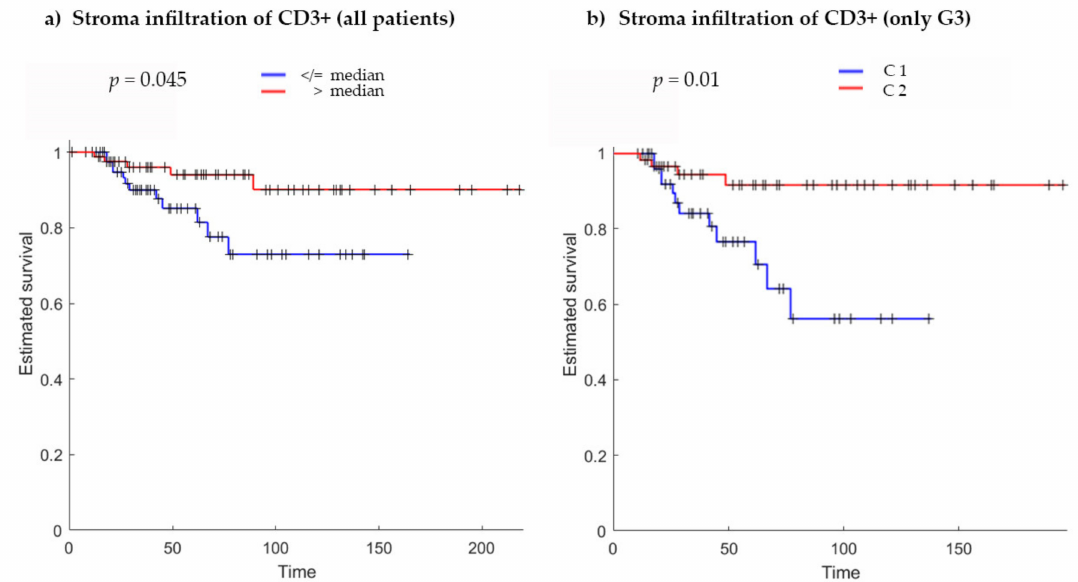
Figure 1. Kaplan–Meier curves for ( a ) stromal infiltration of CD3 + immune cells (all patients) using the median (2882 cells / mm 2 ) as threshold to divide patients into two groups ( p = 0.045). ( b ) Stromal infiltration of CD3 + immune cells (only in G3 subgroup) using the k -means clustering approach ( p = 0.01). C1 with low and C2 with high immune cell infiltration. In each graph, Kaplan–Meier curves present a significant di ff erence between the two groups, showing an increased survival in patients with higher immune cell infiltration. p -Values are calculated using the log-rank test; x -axis, survival in months; y -axis, estimated survival (fraction of